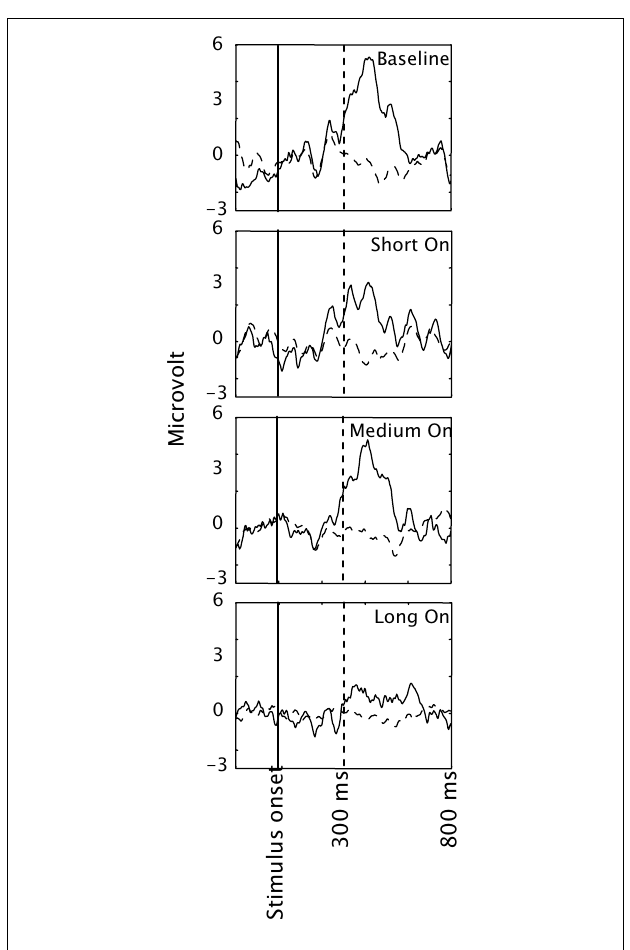
FIGURE 5 | EEG averaged across participants and presented separately for targets (solid lines) and distracters (dashed lines) in the four conditions of Experiment 2. Only data from electrode Pz is presented.